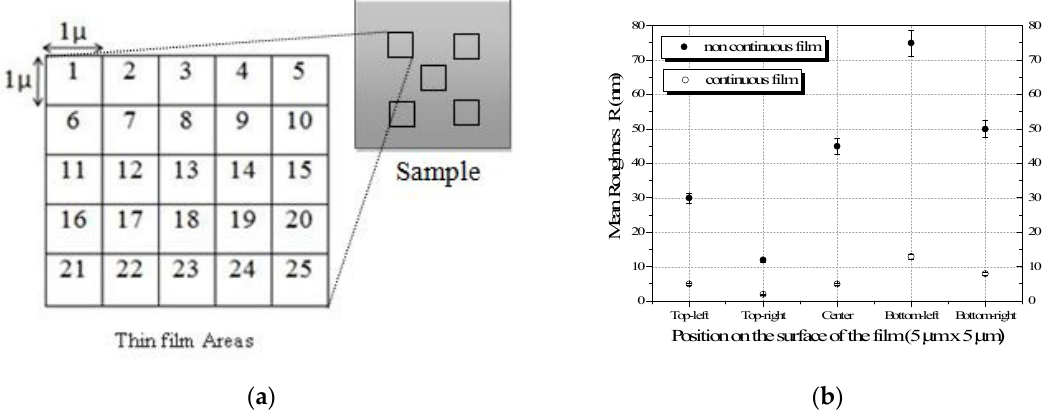
Figure A1. ( a ) Scheme of the 5 × 5 µm AFM micrograph analysis. Each sample surface imaged by AFM standard microscope, has been divided in five zones (see the right top of the figure (a)) and each of these zones has been analyzed in order to obtain a roughness value for each 1 × 1 µm square reported in the scheme. ( b ) The mean roughness value of each zone is here reported as function of the five different zones analyzed for two different kinds of samples (continuous and not continuous).